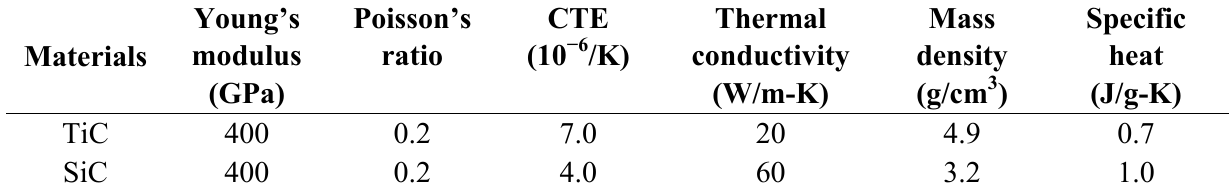
Table 1. Material properties of TiC and SiC.